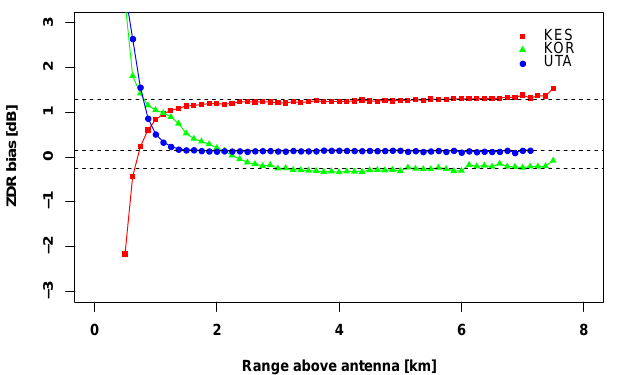
Figure 3. Z dr as a function of altitude above the antenna esti- mated from zenith measurements during precipitation events on 6 June 2015. Each point is a daily average of measurements from a full azimuth rotation of the antenna. The dashed lines indicate the Z dr bias calculated as explained in the